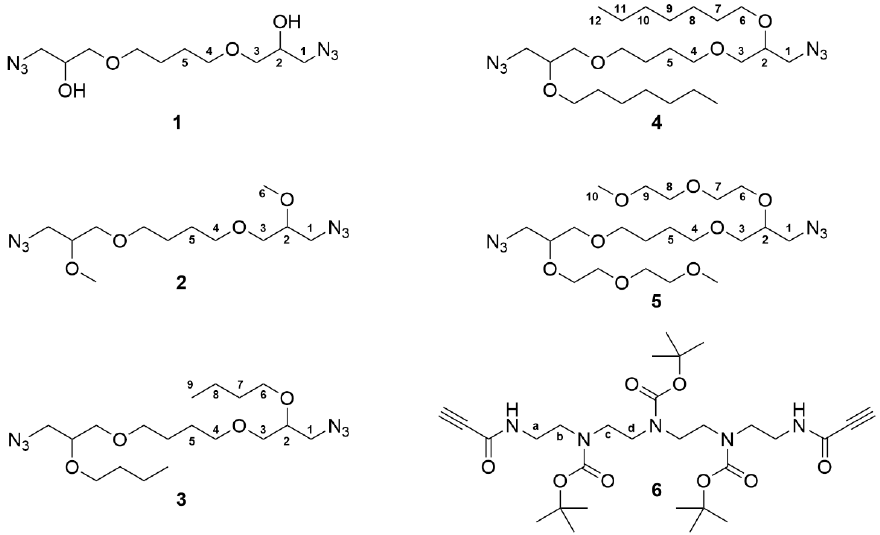
Figure 1. Structures of monomers.